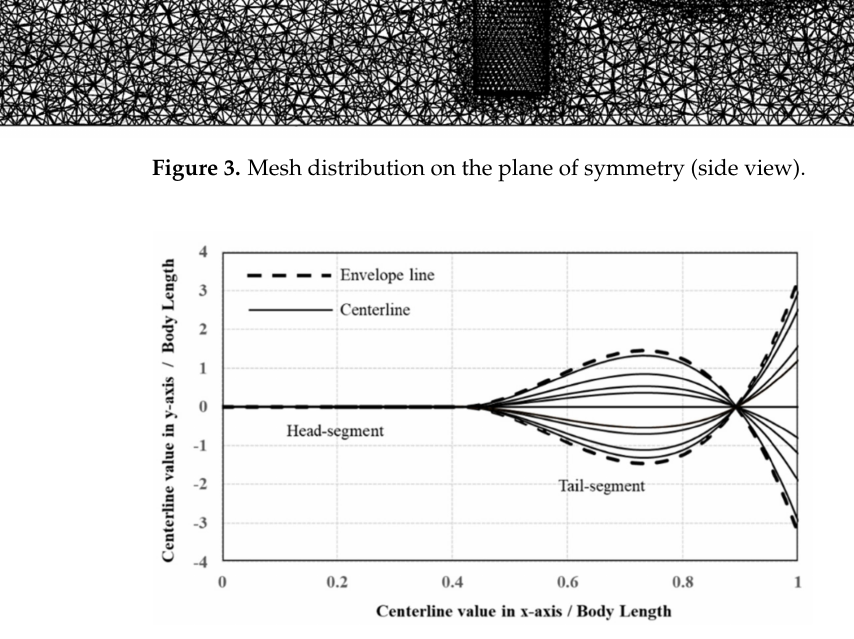
Figure 4. Motion trajectories of the centerline of the